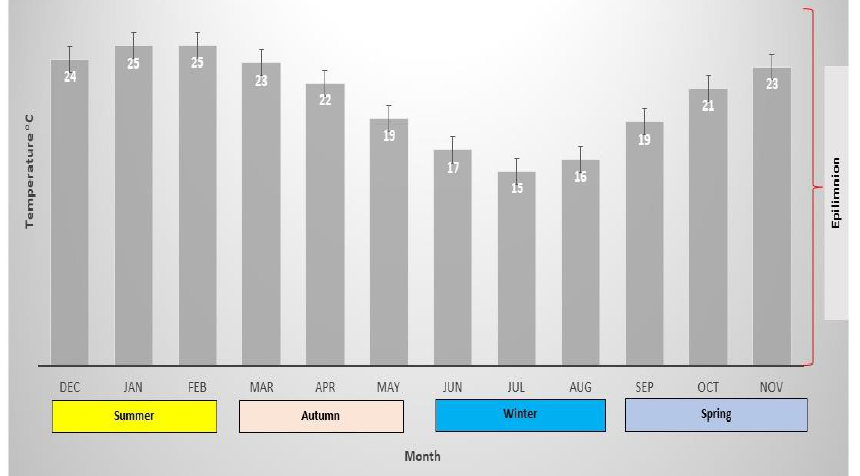
Figure 3. Monthly variations in the average surface temperatures (°C) of the Roodeplaat Dam (bars indicate standard deviations).